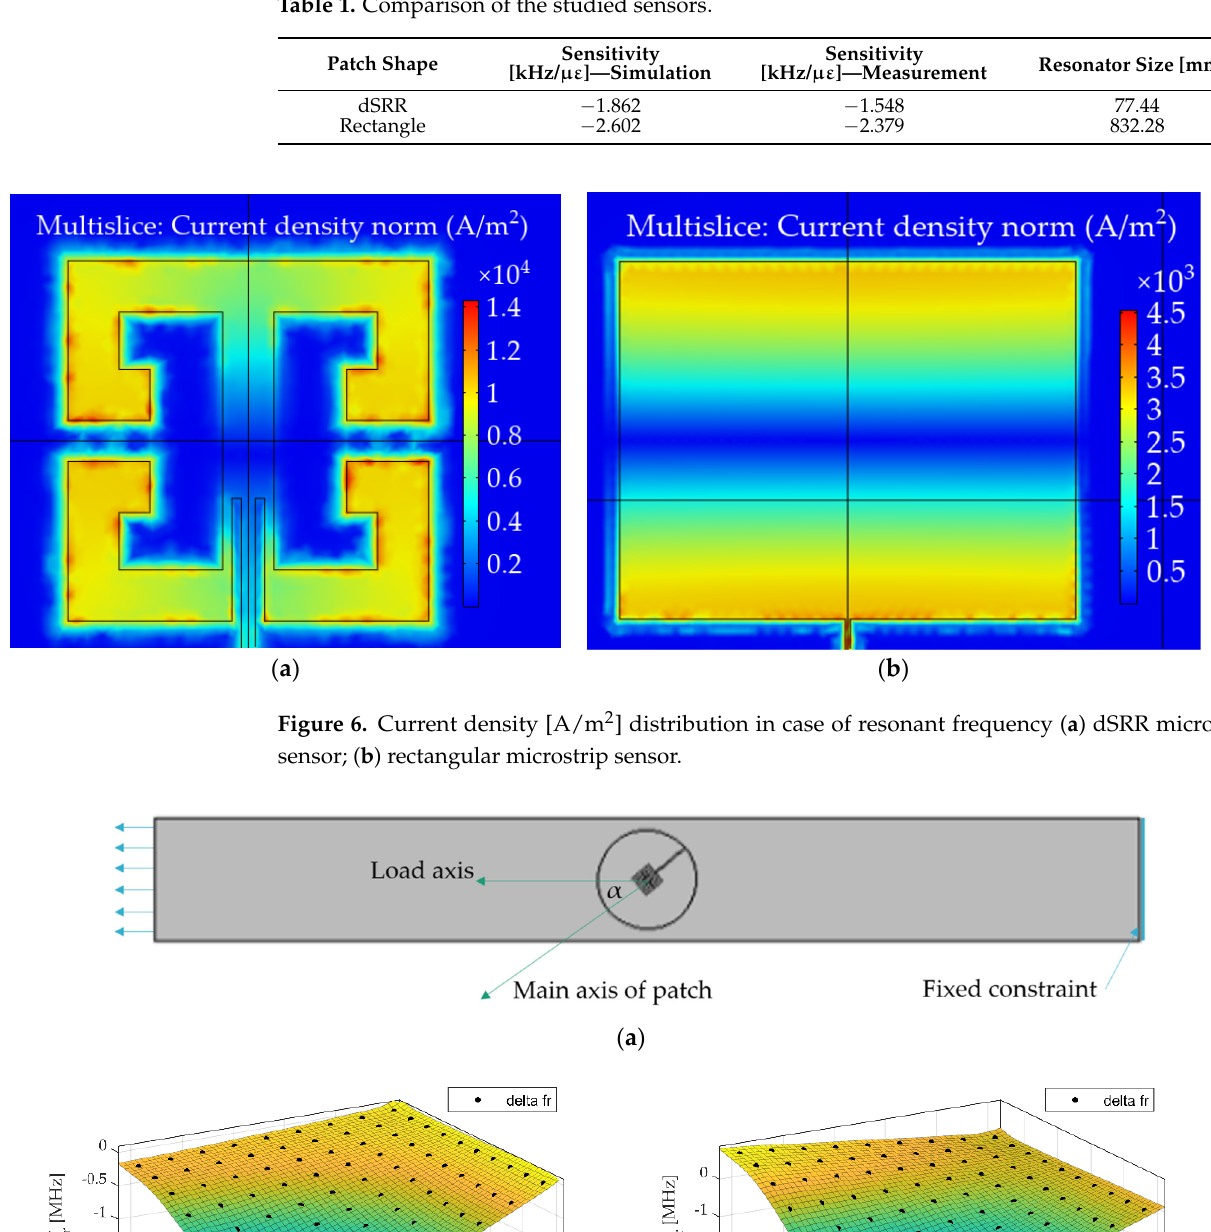
( b ) Figure 5. Influence of strain ε on shifts of resonant frequency Δ f r ( a ) dSRR microstrip sensor; ( b )